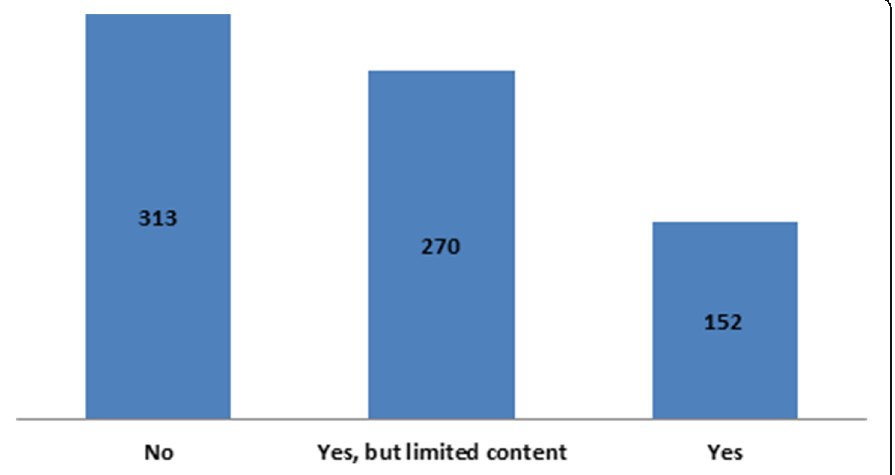
Fig. 4 OER use in the Arab